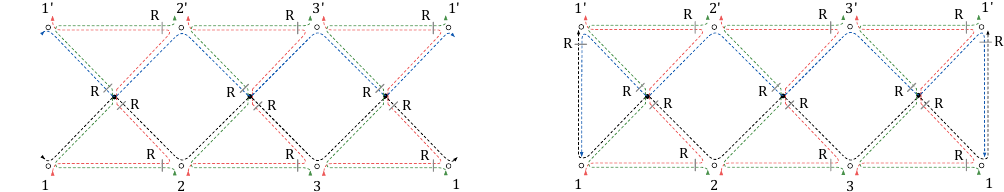
)( u ) of the operator t , x 0 , x 0 1 2 3